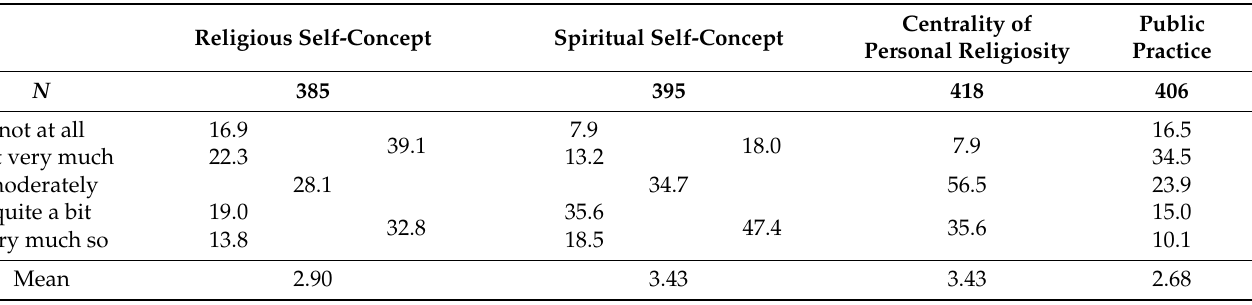
Table 6. Percentage distribution of responses and mean values on religious and spiritual self-concept as well as the centrality of personal religiosity and the frequency of public religious practice among German-speaking pilgrims.